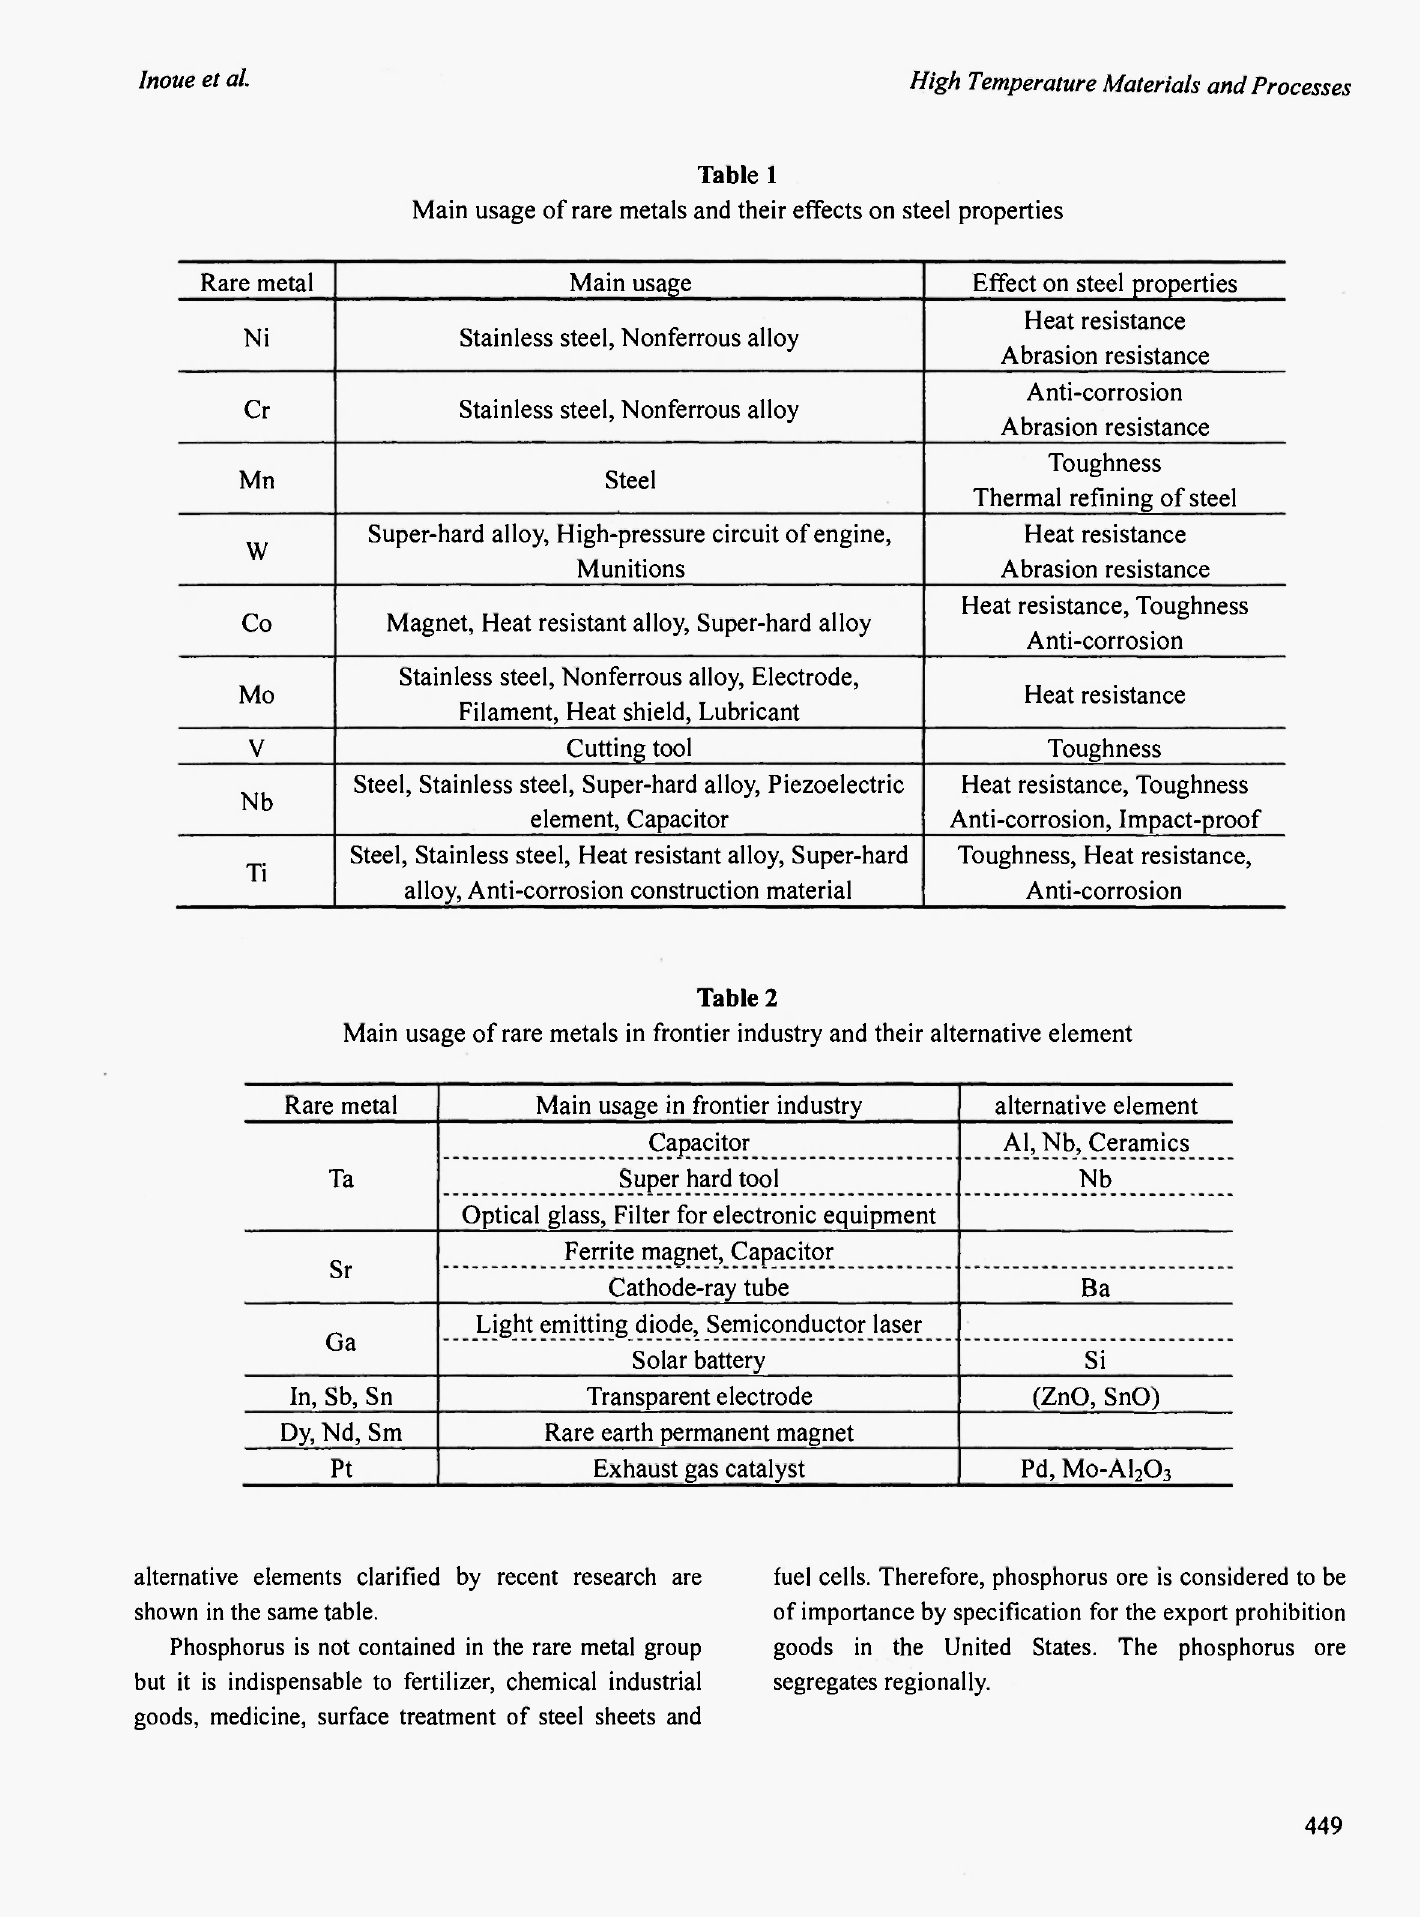
Main usage of rare metals in frontier industry and their alternative